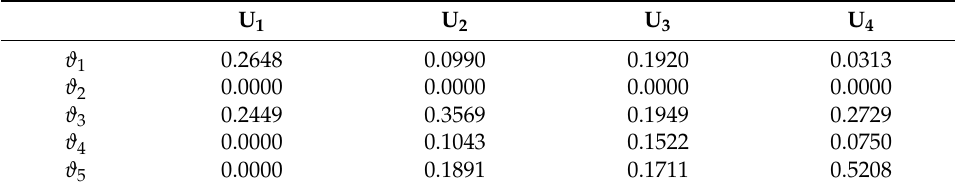
Table 8. The results of NDA ij .